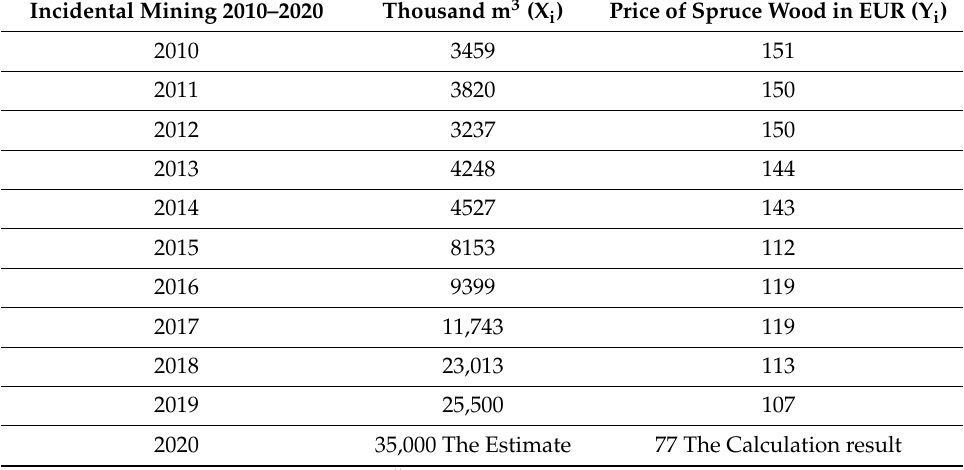
Table 3. The volume of salvage logging and the price of spruce wood (in EUR) between the years 2010 and